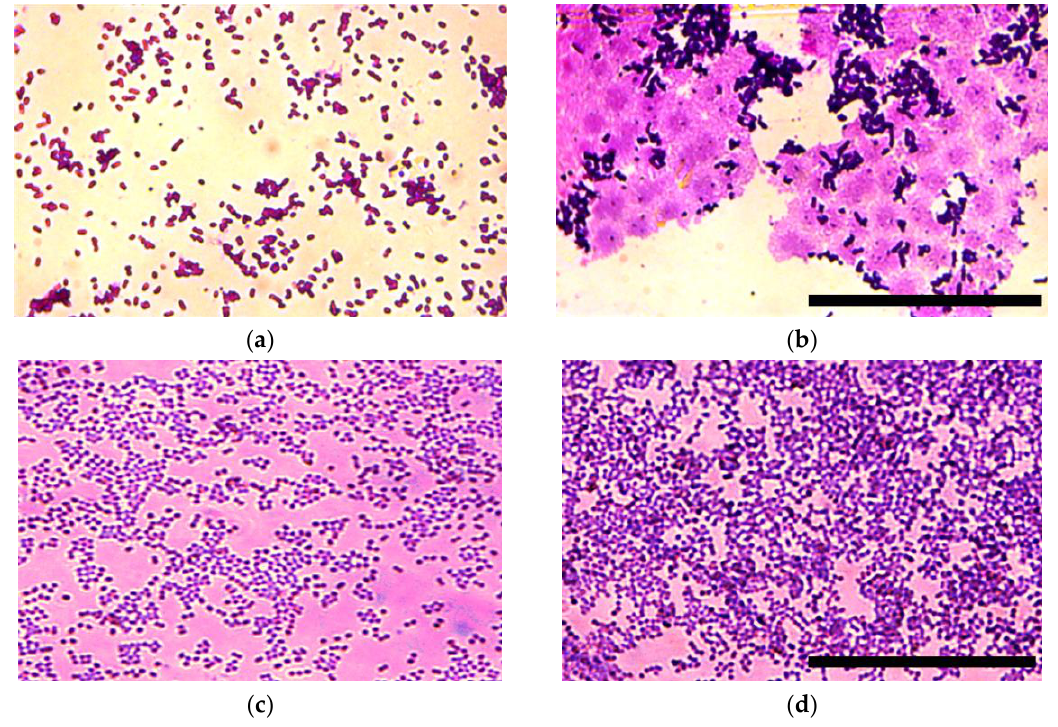
Figure 3. Representative microscopic images depicting the biofilm matrix produced by E. coli ( a , b ) and S. aureus ( c , d ) after 24 h of incubation with ( b , d ) and without ( a , c ) NE. Scale bar is 50 um. In 48 h an increased matrix synthesis was observed in both E. coli and S. aureus strains (Figure 4).